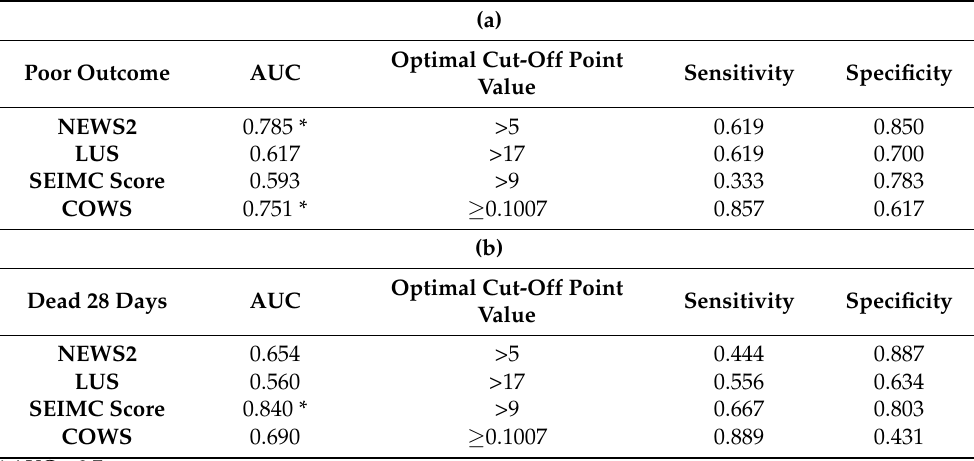
Table 2. Performance of prognostic scores for ( a ) poor outcome and ( b ) dead at 28